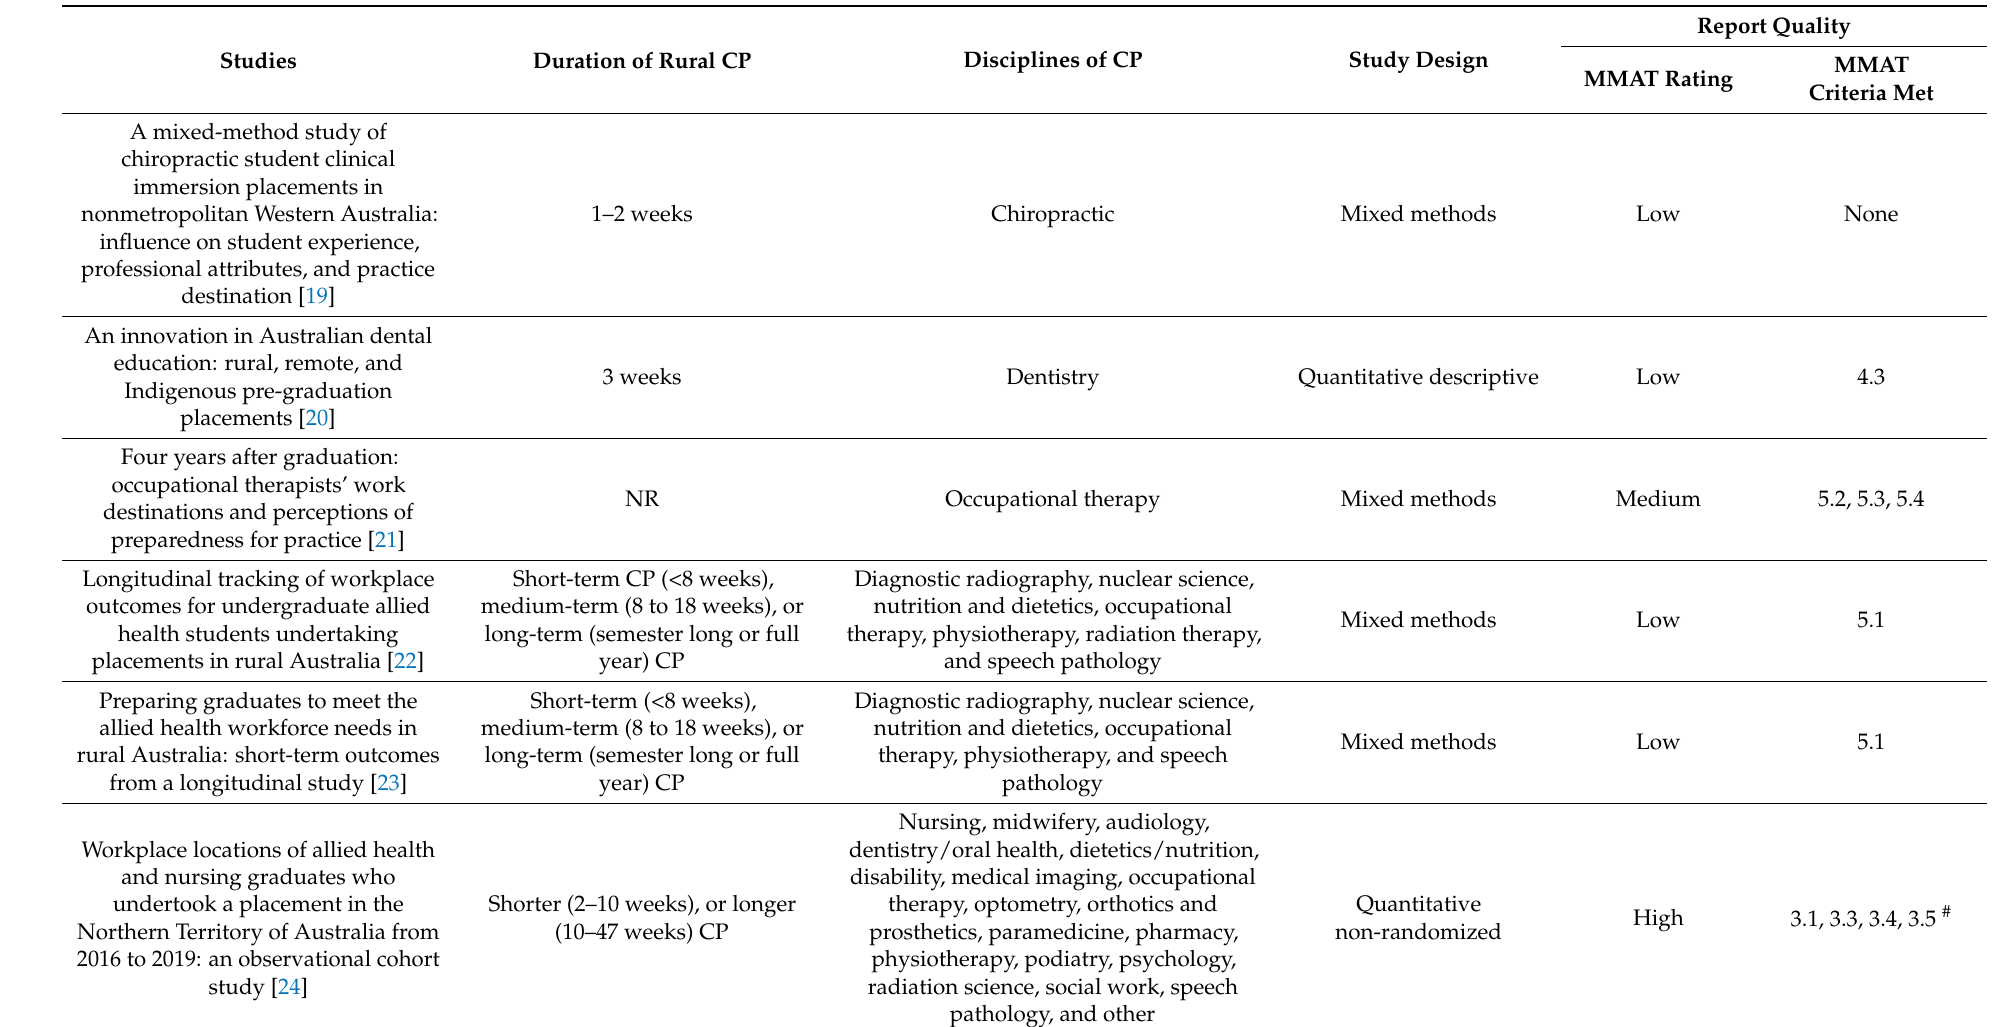
Table 3. Article characteristics and results of quality